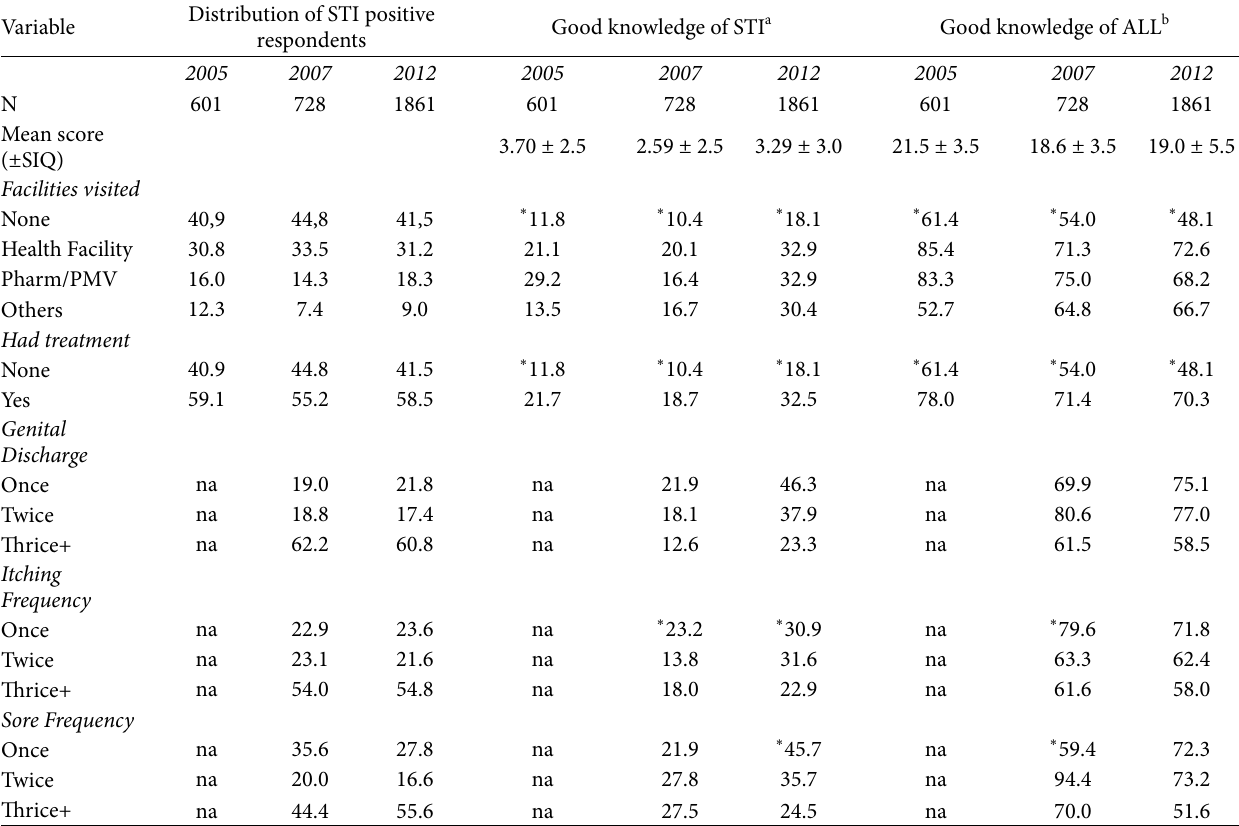
Table 3: Distribution STI positive respondents and association between Frequency of genital discharges, knowledge of STI and HIV/AIDS by facility attended and STI